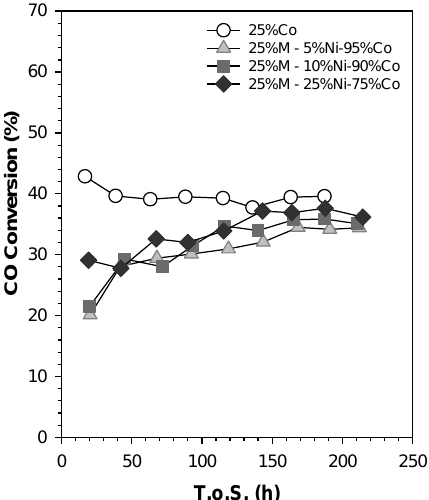
Figure 20. Evolution with T.o.S. of CO conversion for the prepared catalysts (process conditions: T = 220, H 2 / CO = 2 mol / mol, P = 20.6 bar, S.V. = 3.4 slph per g cat ).